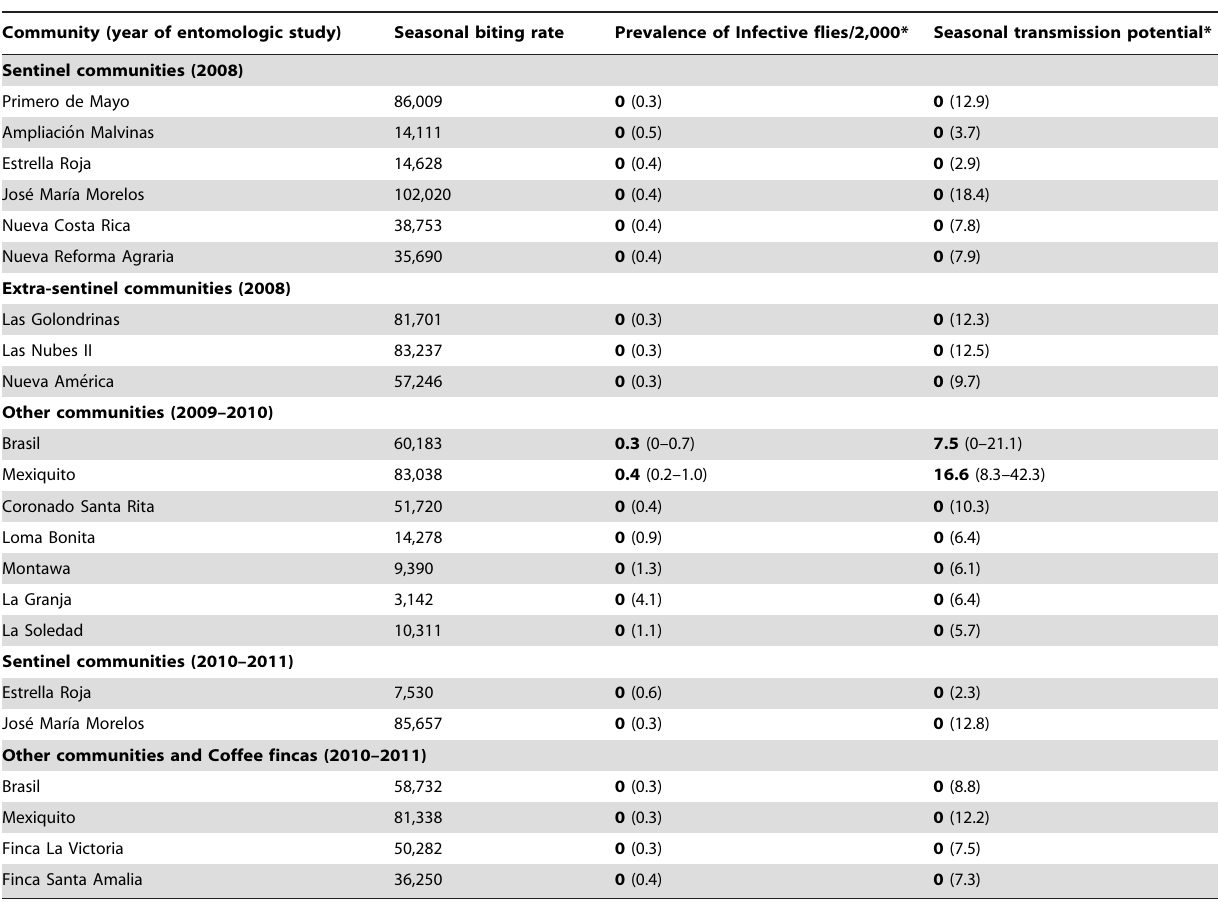
Table 2. Entomological parameters in the focus of Southern Chiapas,